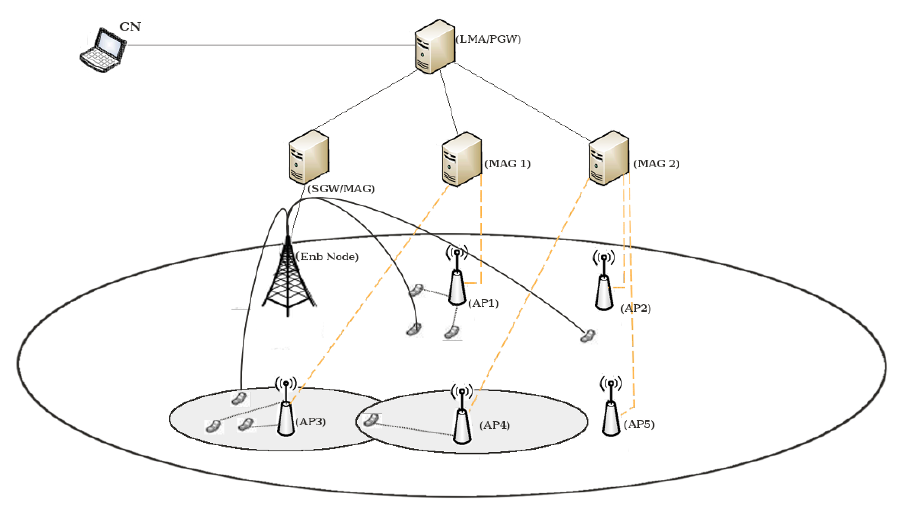
Figure 6. Heterogeneous network topology.